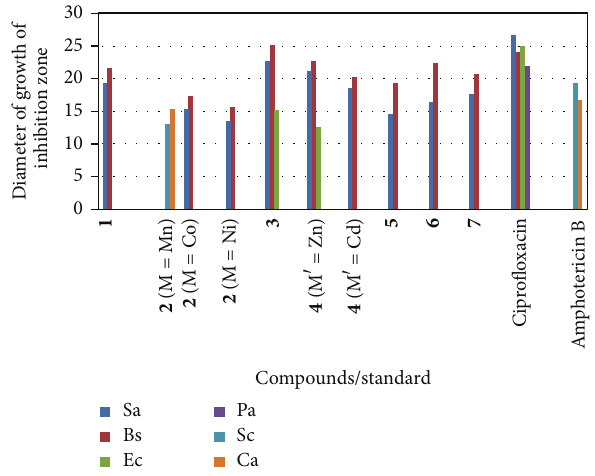
Figure 1: Bar Chart indicating the diameter of growth of inhibition zone for compounds/standard against various microbes.